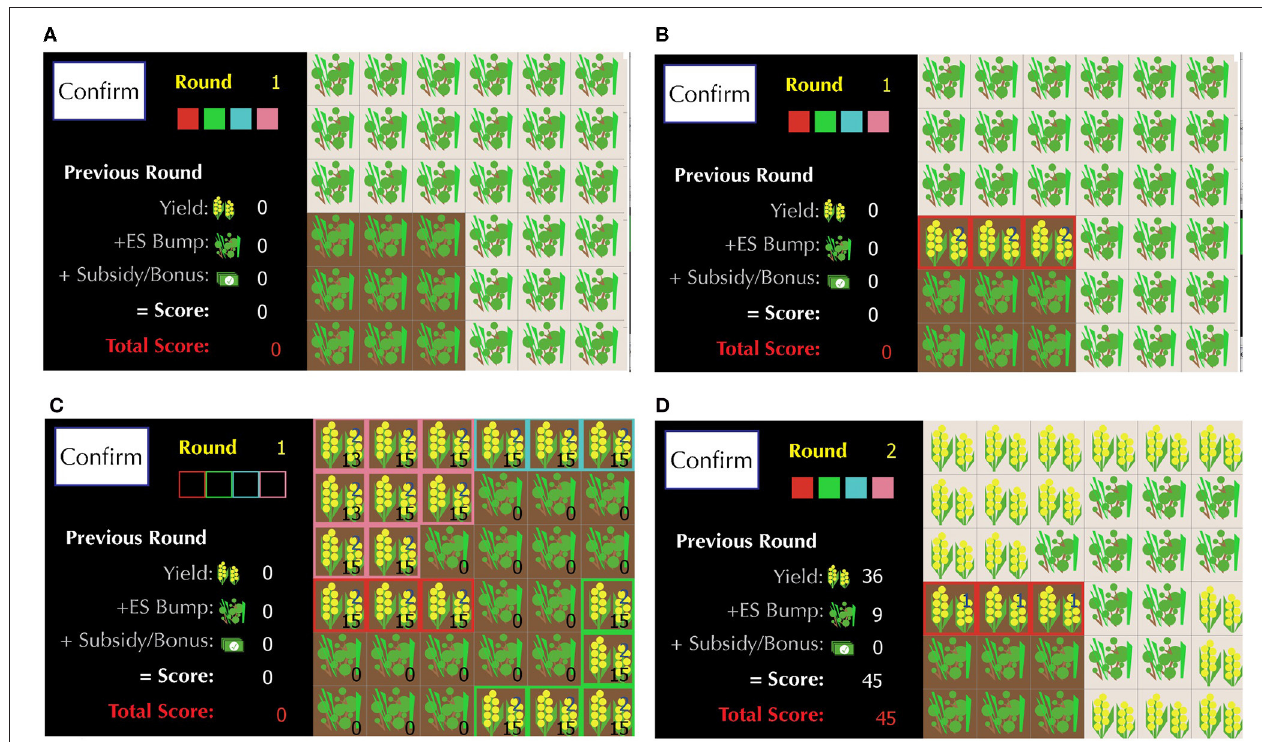
FIGURE 1 | Visual repress entation of the farming landscape in the individual right treatments, players are colour-coded, (A) the bottom left corner is the active player’s 3 × 3 grid at the start of round 1; (B) the active player farmed three cells (the red coloured cells), the black numbers in the red coloured cells are the remaining number of farming cycles with high yield; (C) Game screen of the active player after all four players have made decisions at the end of round 1, the decisions taken by the other players are also visible (the green, blue, and pink cells are farmed by the three other players); (D) game screen of the active player at the start of round 2, the scores of the active player in previous round is shown in the left-hand side of the